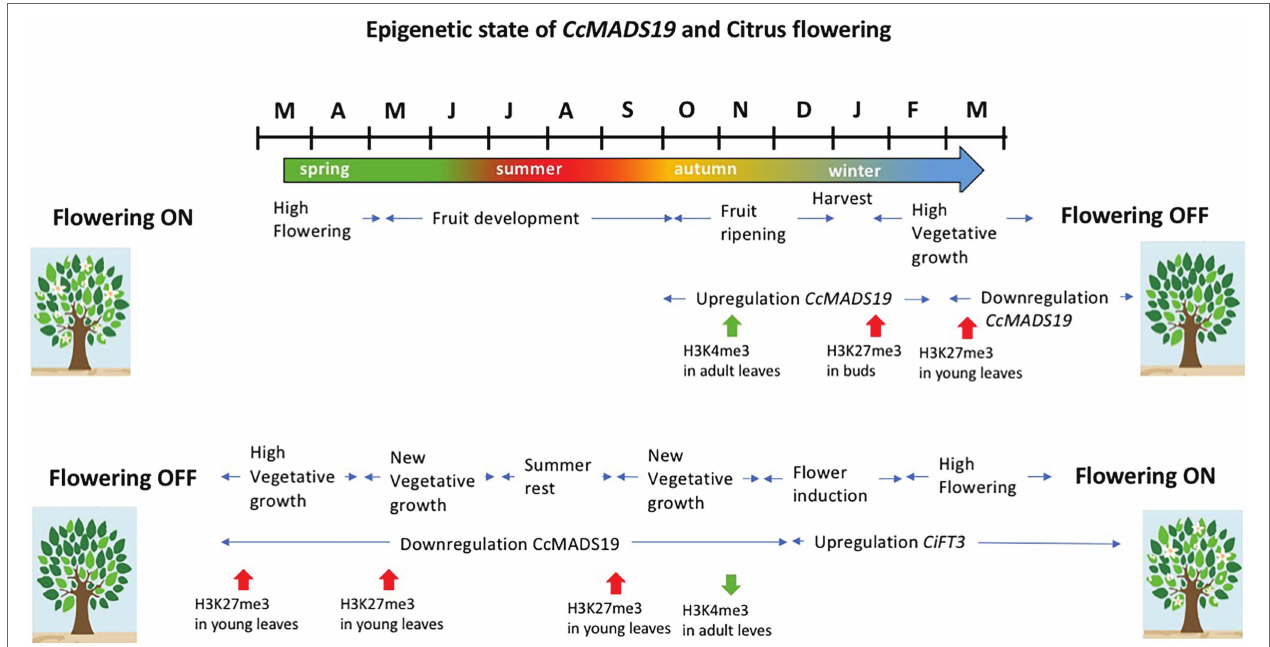
FIGURE 4 | Schematic representation of the events that lead to flowering inhibition or promotion in alternate bearing Citrus , and the epigenetic state of CcMADS19 in leaves and buds in relation to flowering inhibition and flowering resetting. See text for